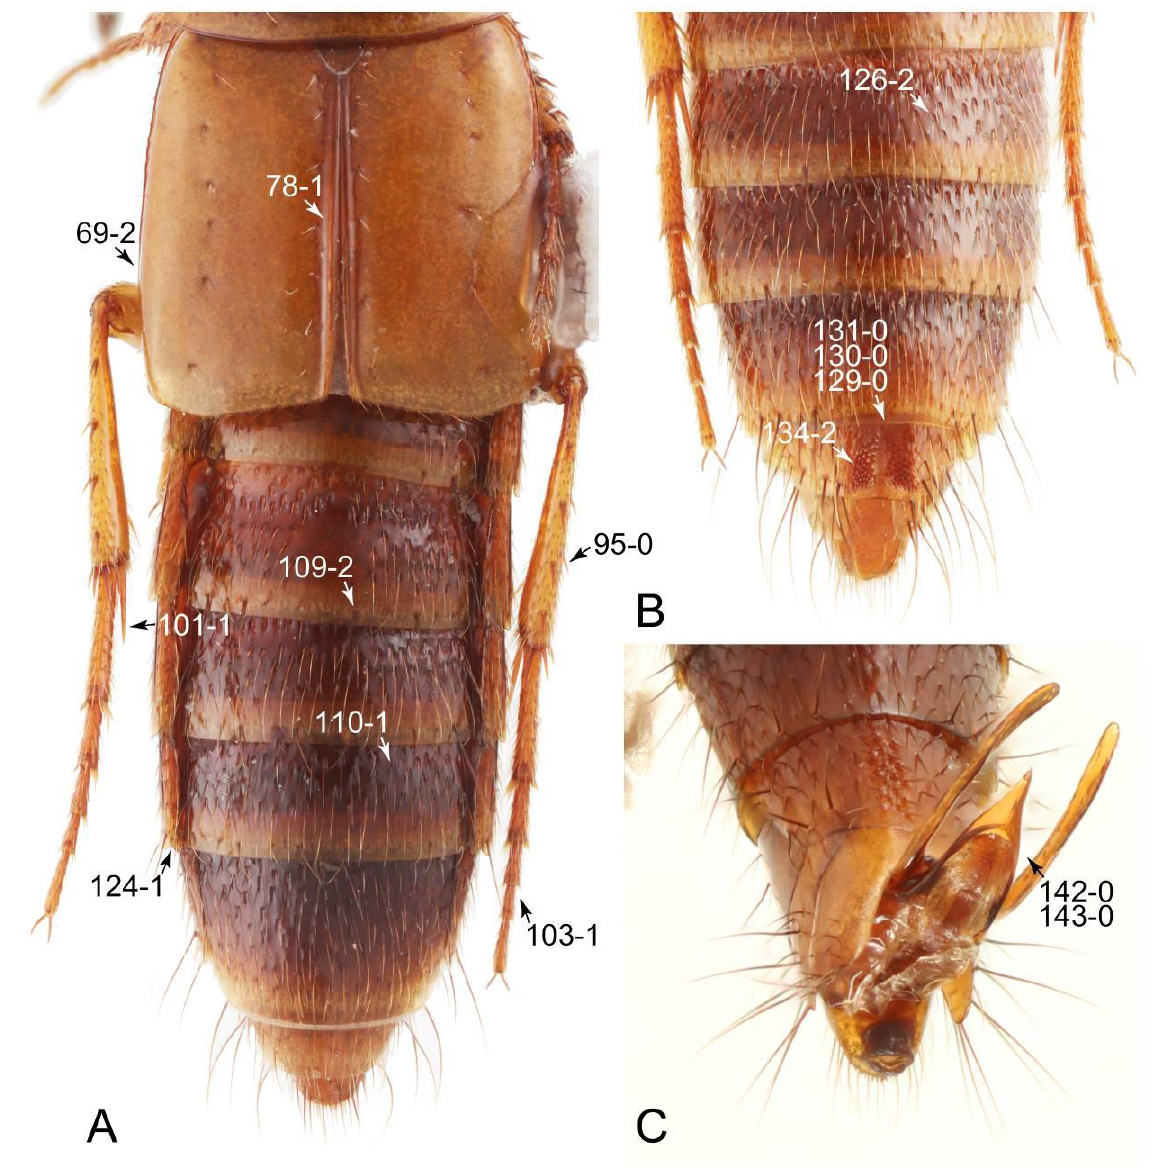
Figure 66. Photographs of body parts of Mycetoporinae, enlarged. ( A ) elytra, hindlegs, and abdomen of Carphacis effrenatus , dorsal view. ( B ) male abdomen of Carphacis effrenatus , ventral view. ( C ) male abdominal terminalia and genitalia of Bolitopunctus sp., ventral view. Characters and character states (format X-X) are indicated on each